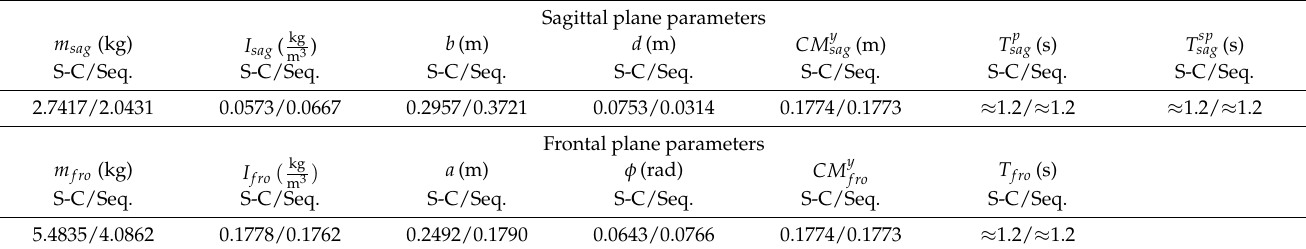
Table 7. Dynamic model parameters of the best solutions obtained by structure-control (S-C) and sequential (Seq.) design processes.